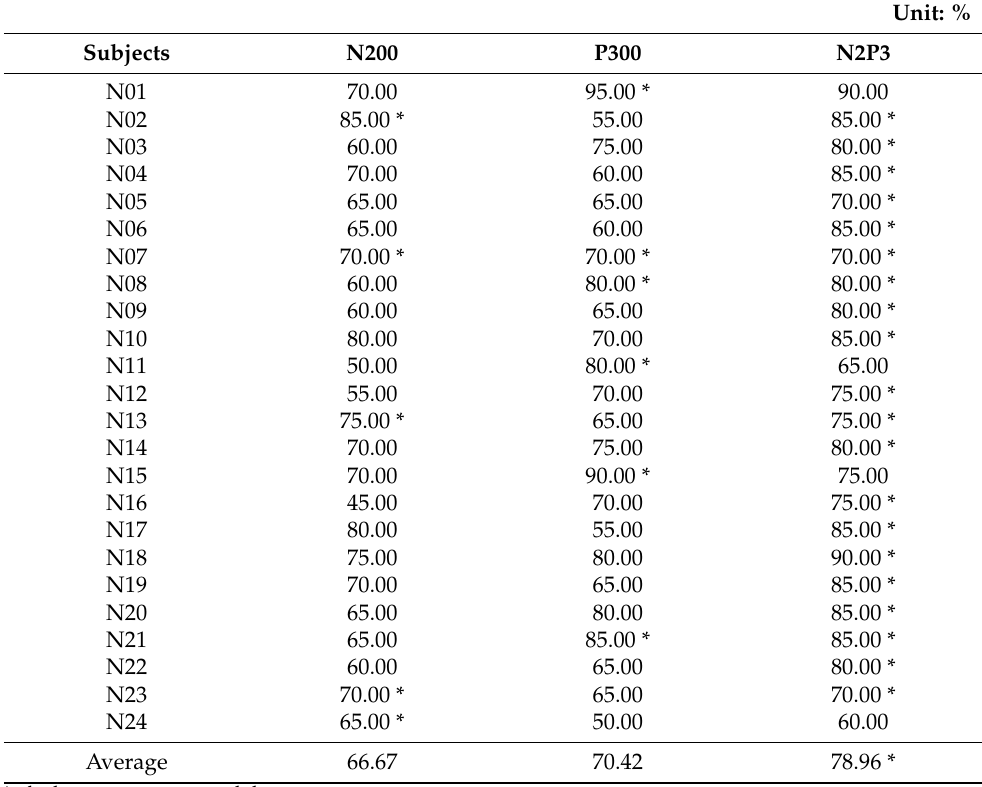
Table 7. Average accuracies based on the NN